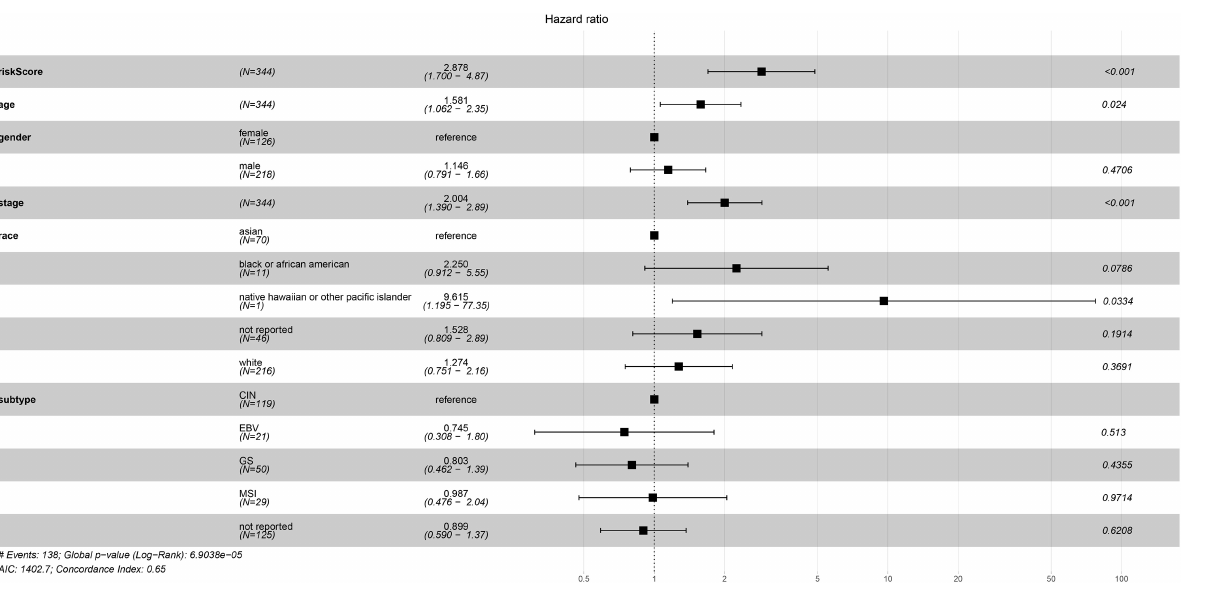
FIGURE 4 | Multivariate Cox regression analysis of clinicopathologic factors and risk score for STAD in TCGA